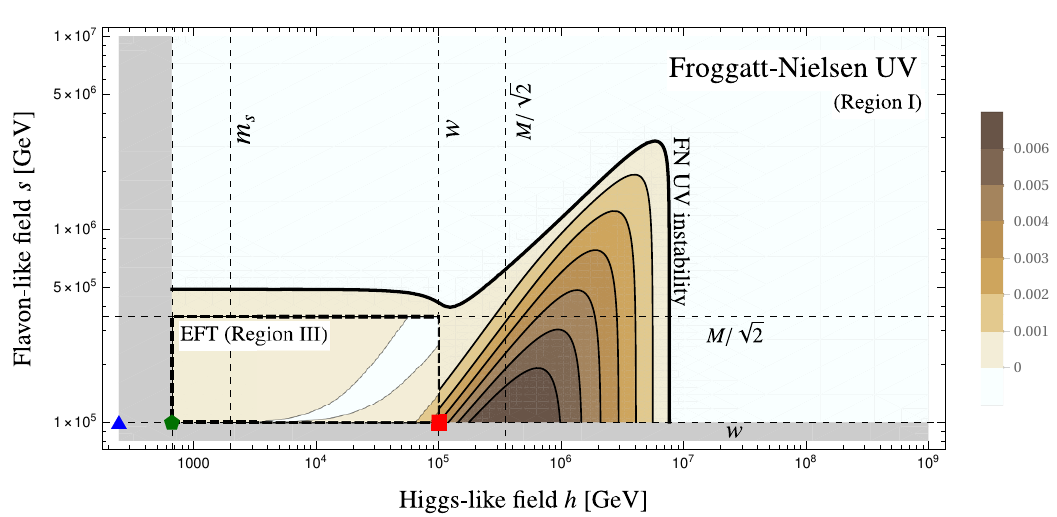
Figure 6 . UV completion ( M = 5 (cid:2) 10 5 GeV, m (cid:27) = 2 TeV) with the UV model matched to the (cid:13)avon EFT at (cid:22) = h = w . The white island corresponds to the residual instability region from (cid:12)gure 5 that is left over once the light b quark and higher dimensional operators are taken into account.